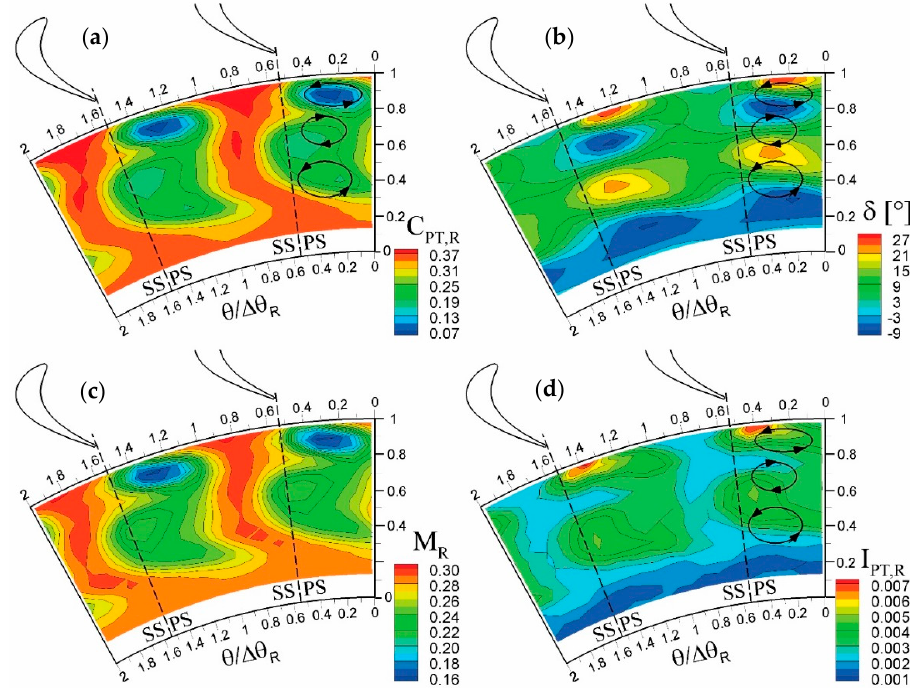
Figure 10. Rotor-exit relative flow field in OP4, ( a ) relative total pressure coefficient; ( b ) deviation angle; ( c ) relative Mach number; ( d ) unresolved unsteadiness.